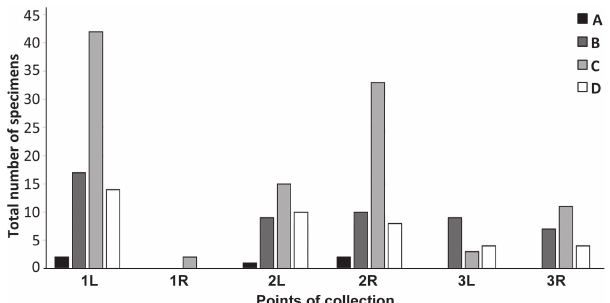
Fig. 14. Distribution of gonad maturity stages of Loricariichthys melanocheilus females in the rio Ibicuí by point of collection. 1L, 2L and 3L = Lagoon of points 1, 2 and 3 respectively, 1R, 2R and 3R = River of points 1, 2 and 3